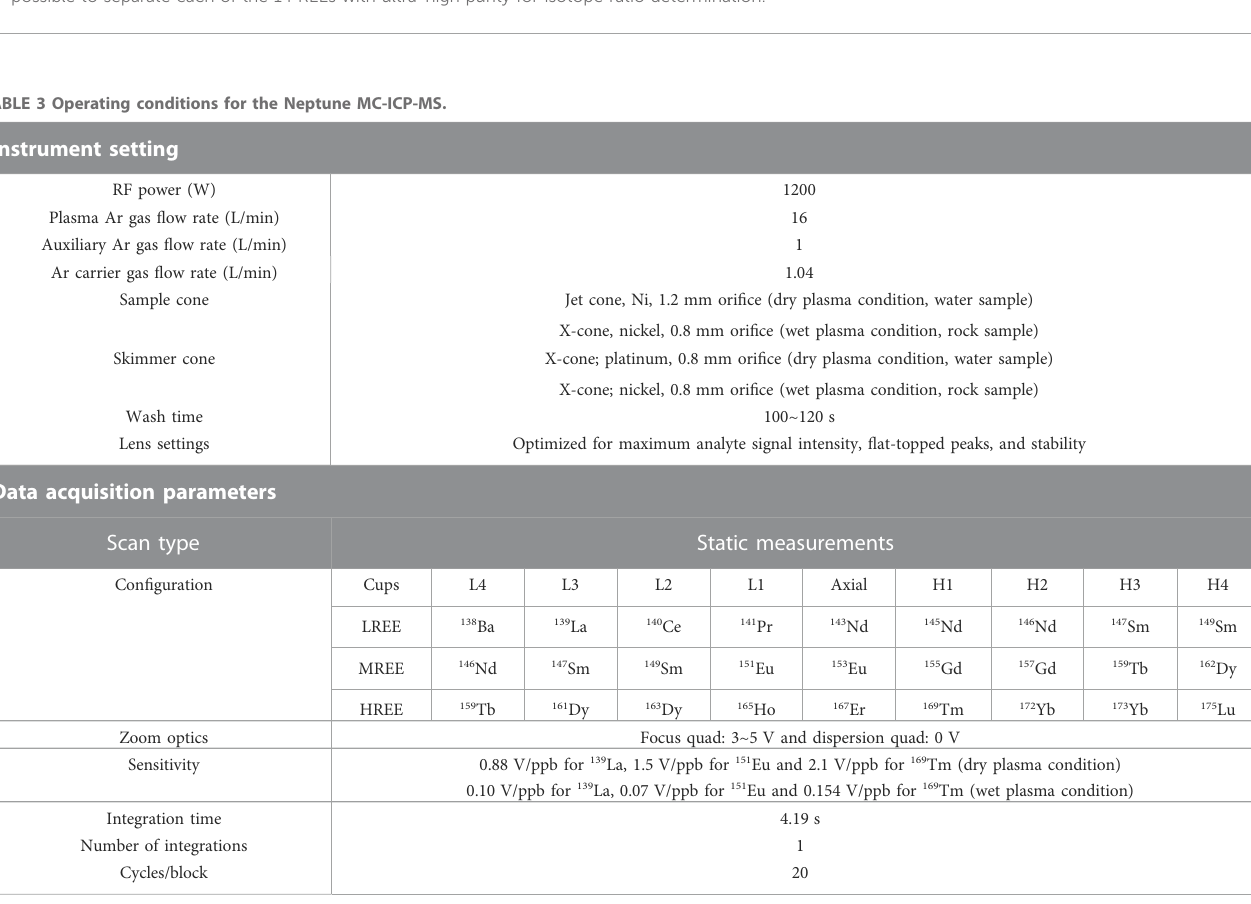
FIGURE 1 Elution diagram of the REEs using a quartz glass column (ø 3 mm, length 98 mm) fi lled with 0.8 mL of the cation-exchange resin (Biorad AG 50WX-8, 200 – 400 mesh) and 2-hydroxyisobutyric acid (HIBA, pH 4.6) as the eluant (Supplementary Table S1). As can be seen in the fi gure, the elution range for each group (LREE, MREE and HREE) in this study was separately indicated by the concentration and amount of HIBA. In addition, as evident in the MREE part, it is possible to separate each of the 14 REEs with ultra-high purity for isotope ratio determination.